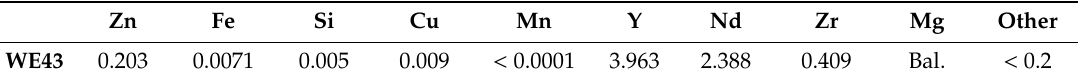
Table 1. Chemical composition (wt %) of WE43 magnesium alloy.